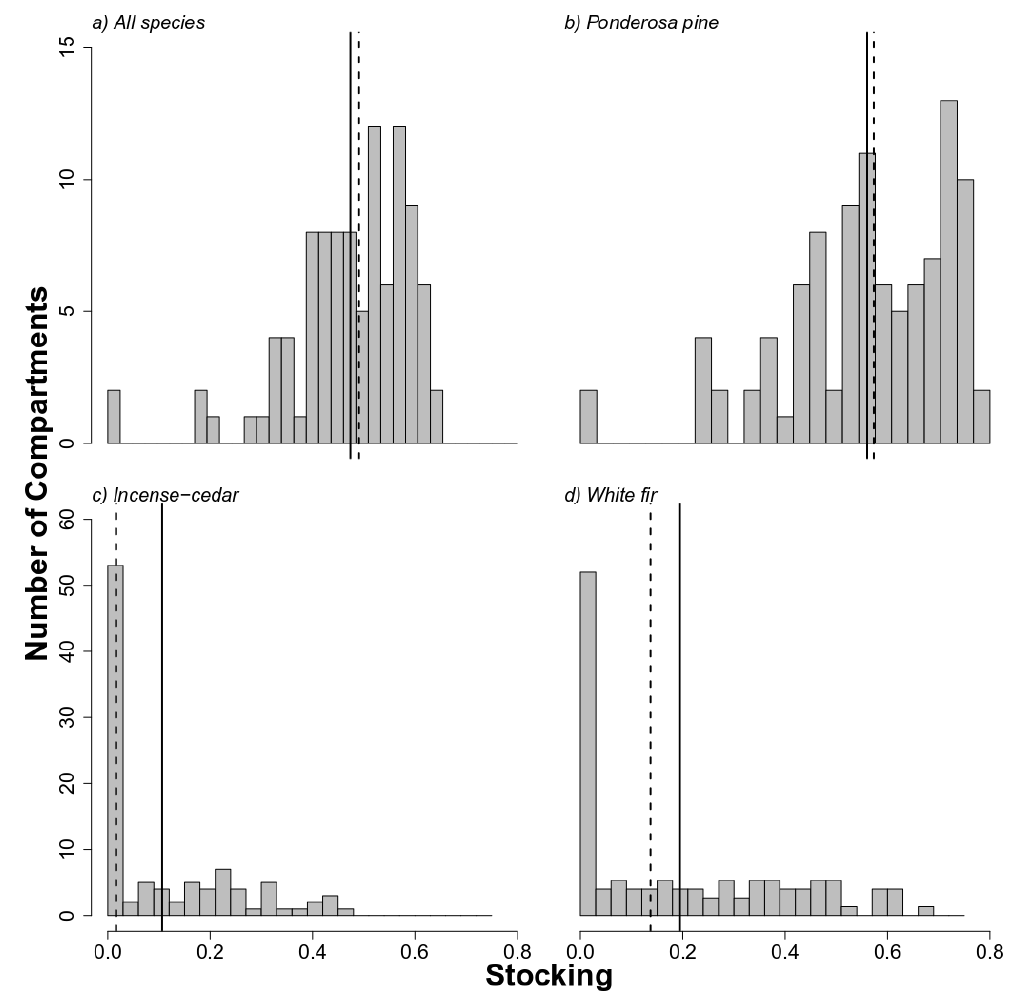
Figure 3. Histograms of 1935 stocking proportion calculated at 0.0016 ha for 100 compartments for ( a ) all species, ( b ) Ponderosa pine, ( c ) white fir, and ( d ) incense-cedar, with mean (solid black line) and median (dashed line). The scale on y-axis are different for both panels of figure.